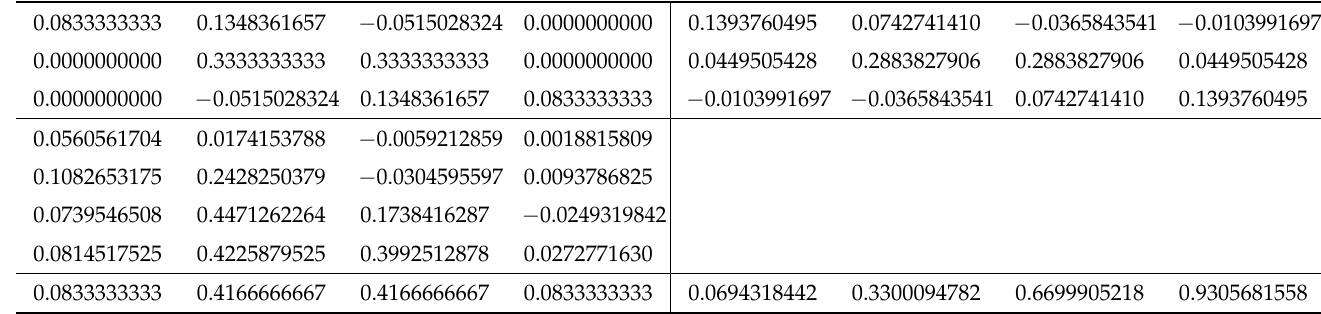
Table A27. eL4|G4